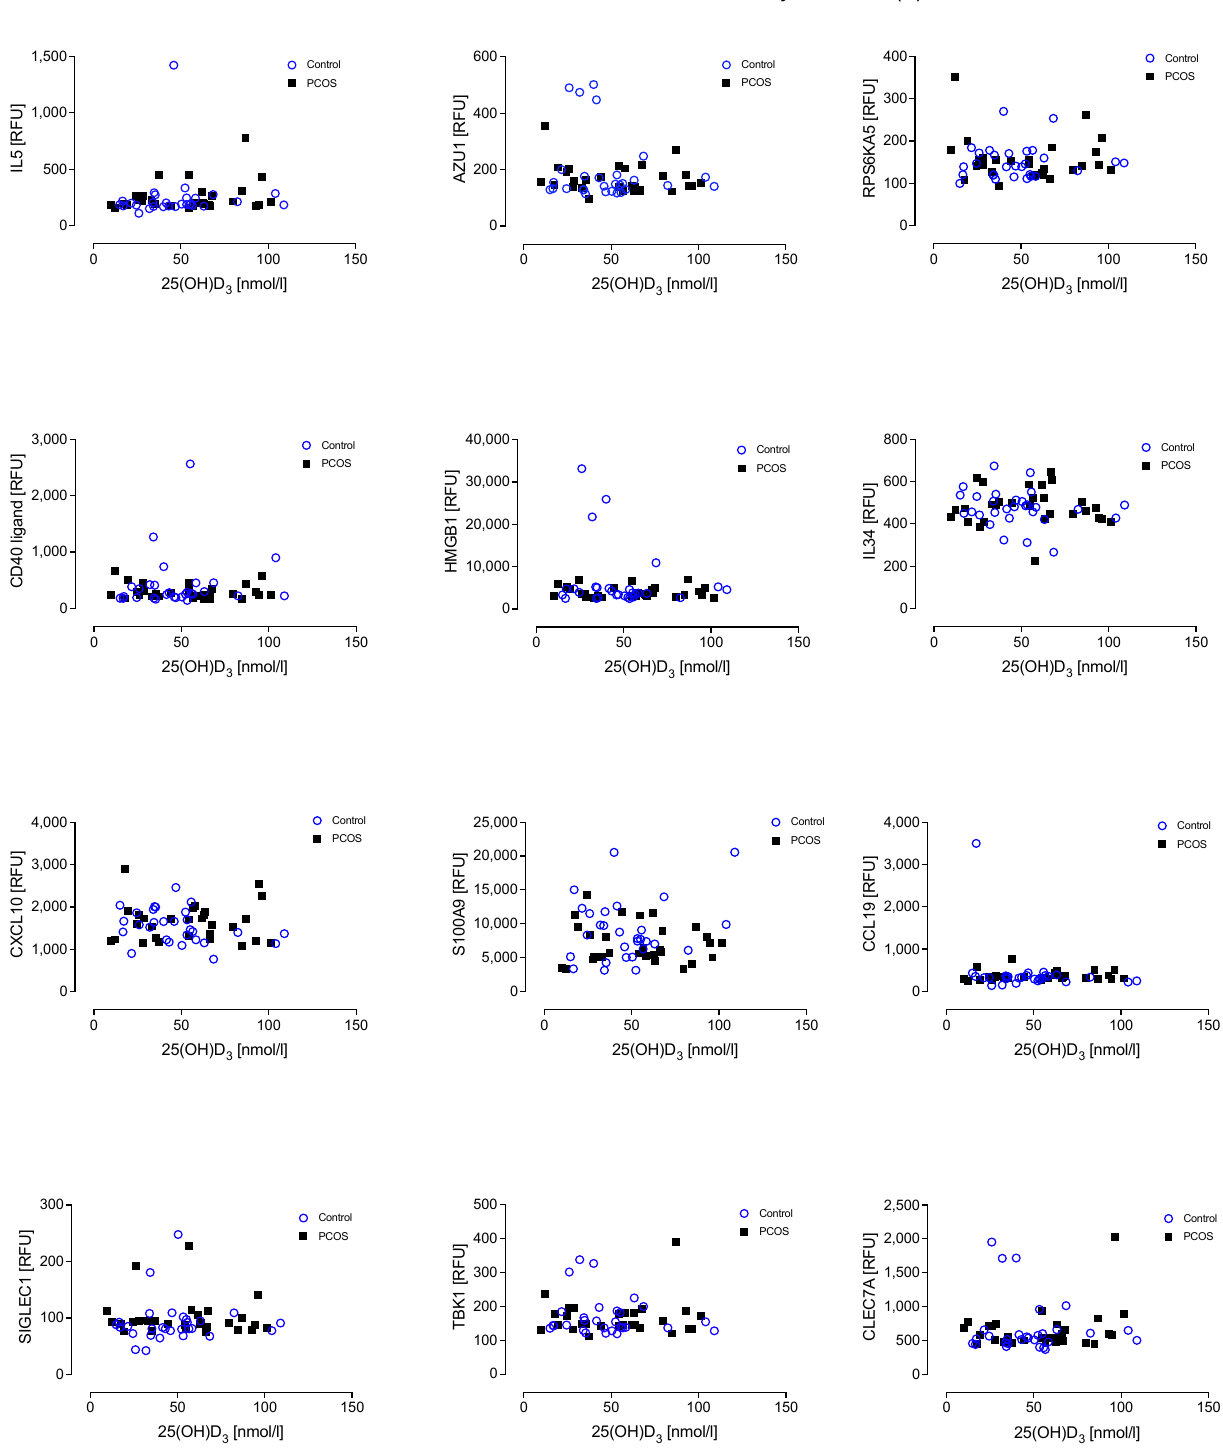
Figure 2. No relationship was found between Vitamin D 3 and the inflammatory markers Interleukin-5 (IL5), Azurocidin (AZU1), Ribosomal protein S6 kinase alpha-5 (RPS6KA5), CD40 ligand (CD40LG), High mobility group protein B1 (HMGB1), Interleukin-34 (IL34), C-X-C motif chemokine 10 (CXCL10), Protein S100-A9 (S100A9), C-C motif chemokine 19 (CCL19), Sialoadhesin (SIGLEC1), Serine/threonine-protein kinase (TBK1) and C-type lectin domain family 7 member A (CLEC7A).